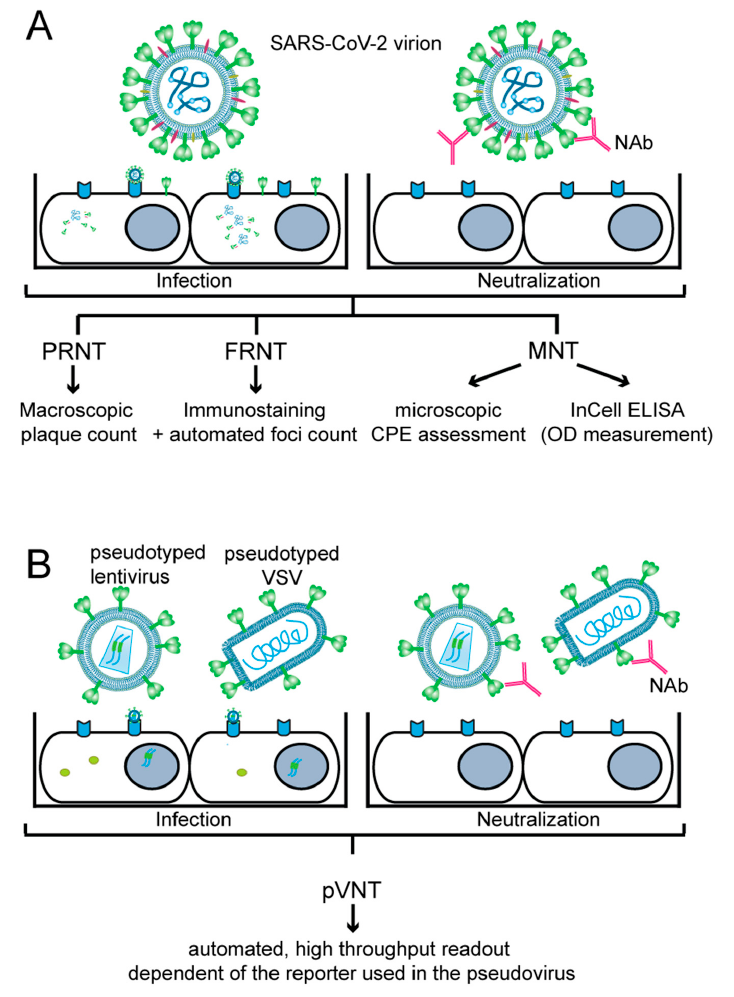
Figure 1. Principle of cell-culture-based neutralization assays. ( A ) Conventional virus-neutralization test (VNT) and ( B ) pseudovirus-neutralization test (pVNT) are laboratory methods primarily used for identifying whether neutralizing antibodies (NAbs) against SARS-CoV-2 are present in the patient sample. Both tests involve incubating patient serum with the virus ( A ) or pseudovirus ( B ), and then inoculating onto cell culture. If NAbs are present and the virus is neutralized, the cells will not be infected. Accordingly, there will be a reduction in plaque formation or expression of virus proteins in the plaque-reduction neutralization assay (PRNT) and focus-reduction neutralization assay (FRNT), respectively. If NAbs are not present, the virus will infect the cells. In pVNT, a recombinant or chimeric virus with SARS-CoV-2 S protein on its surface bearing a reporter gene is used for increased safety and easier readout. A reduction in the reporter gene expression reflects the presence of NAbs.